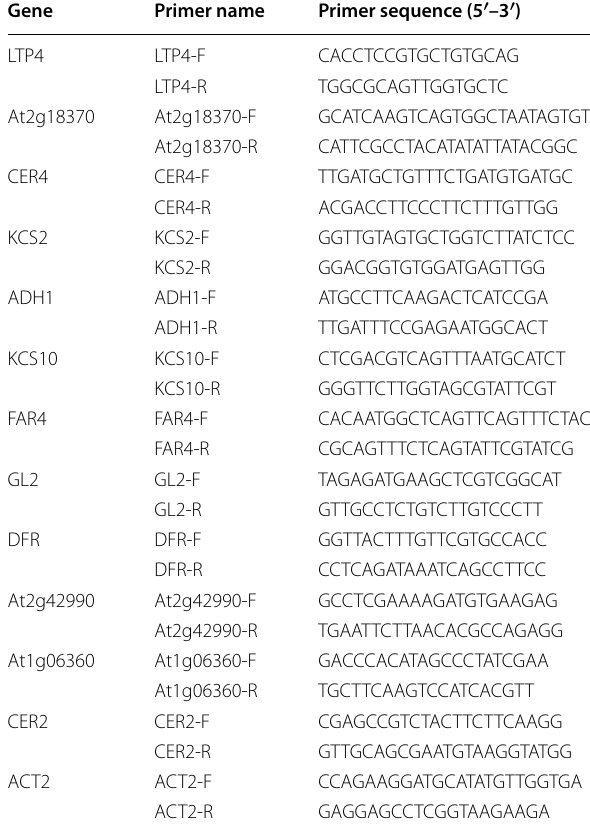
Table 1 qRT-PCR primer sequence Gene Primer name